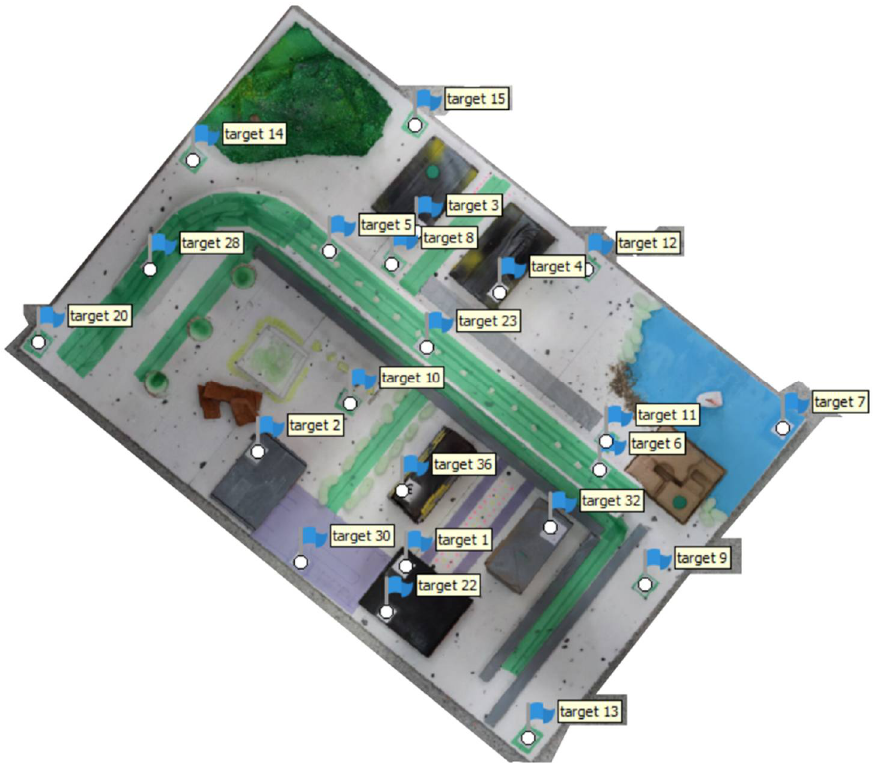
Figure 3. Positions of F-points (marked with blue flags with the target and number inscription).